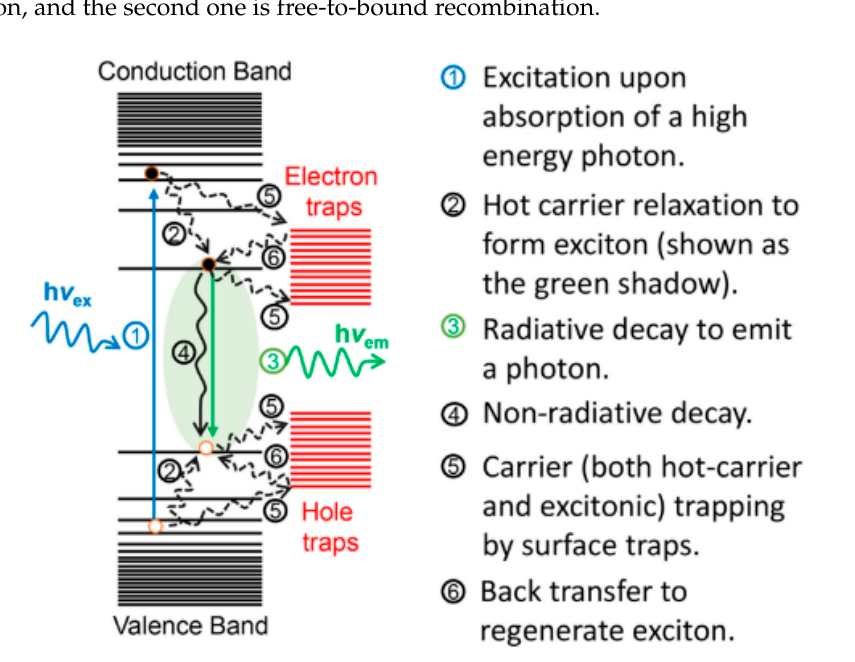
Figure 1. Scheme of the basic processes involving various excited states in a quantum dot upon photoexcitation. Reproduced with permission from [75]. Copyright American Chemical Society, 2017.